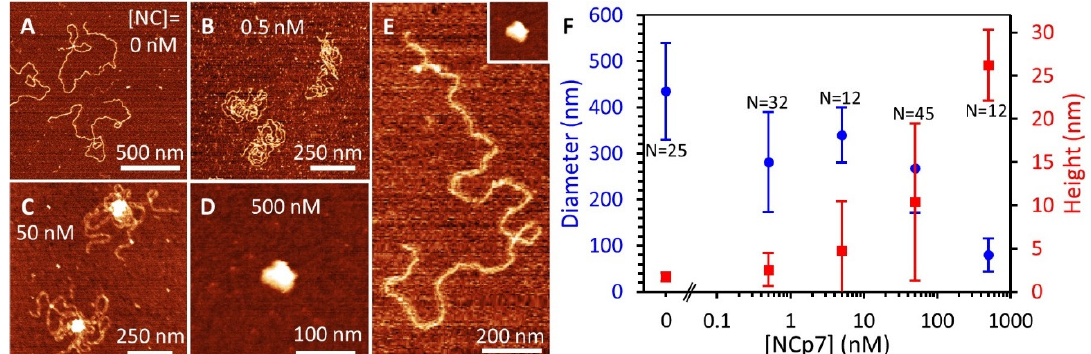
Figure 8. AFM images of NC-DNA complexes. ( A ) A 7.2 kbp DNA molecule, in the absence of protein, assumes a spread-out conformation, consistent with the WLC model, with infrequent DNA overlaps. ( B ) Low concentrations of NC (<10 nM) stabilize crosslinking of DNA loops, reducing the spread of the DNA but not producing a condensed globule. ( C ) Moderate NC concentrations create a highly condensed DNA globule that partially condenses the DNA. ( D ) Saturating quantities of NC (>100 nM) condense the entire DNA molecule with no bare DNA remaining. Note the panels show different length scales. ( E ) Comparison of a protein-free DNA and fully compacted DNA-NC globule (inset) on the same scale. ( F ) Average diameter and height of DNA molecules as a function of NC concentration, with total number of DNA molecules measured (N) listed for each condition. Increasing NC compacts the DNA, resulting in a smaller maximum DNA diameter on the surface (blue) and higher maximum height due to the formation of a tight 3D globule consisting of many layers of DNA (red). Error bars represent standard deviation, showing the spread of values for individual DNA